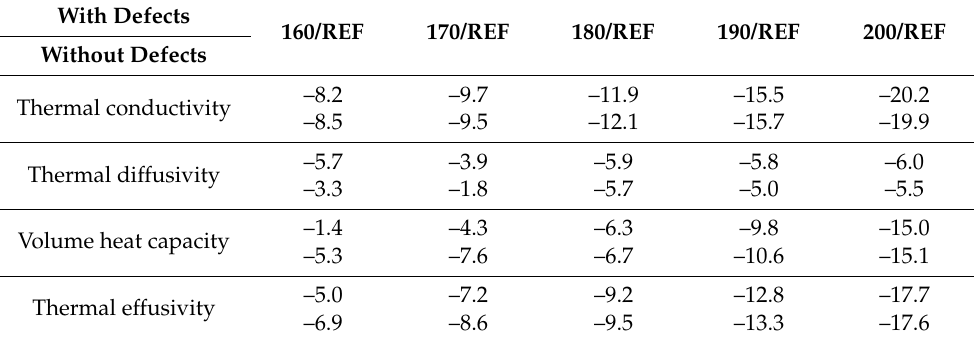
Table A1. Changes in thermal characteristics of heat-treated birch wood in comparison to the reference (untreated) birch wood in %.